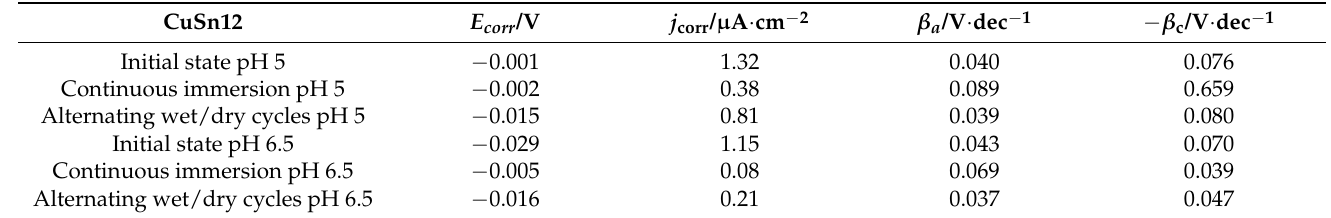
Table 10. Corrosion parameters of sulphate patinated CuSn12 bronze obtained by Tafel extrapolation